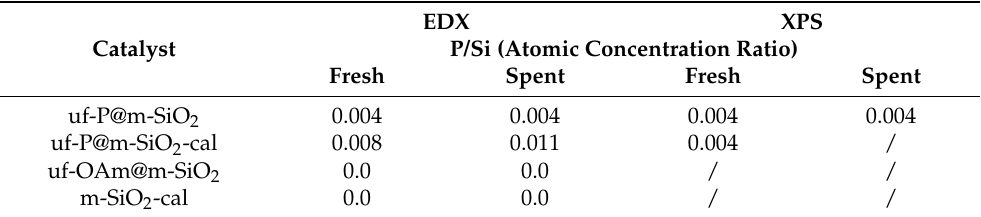
Table 2. SEM-EDX and XPS determined P/Si atomic concentration ratio of the catalysts before and after the catalytic performance test.